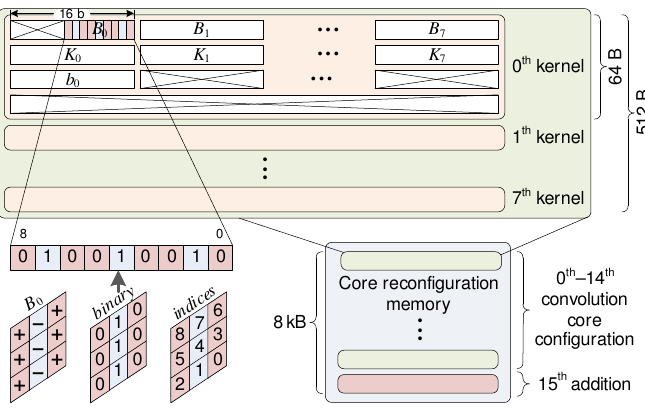
Figure 6. Parameter arrangement in the convolutional core’s configuration